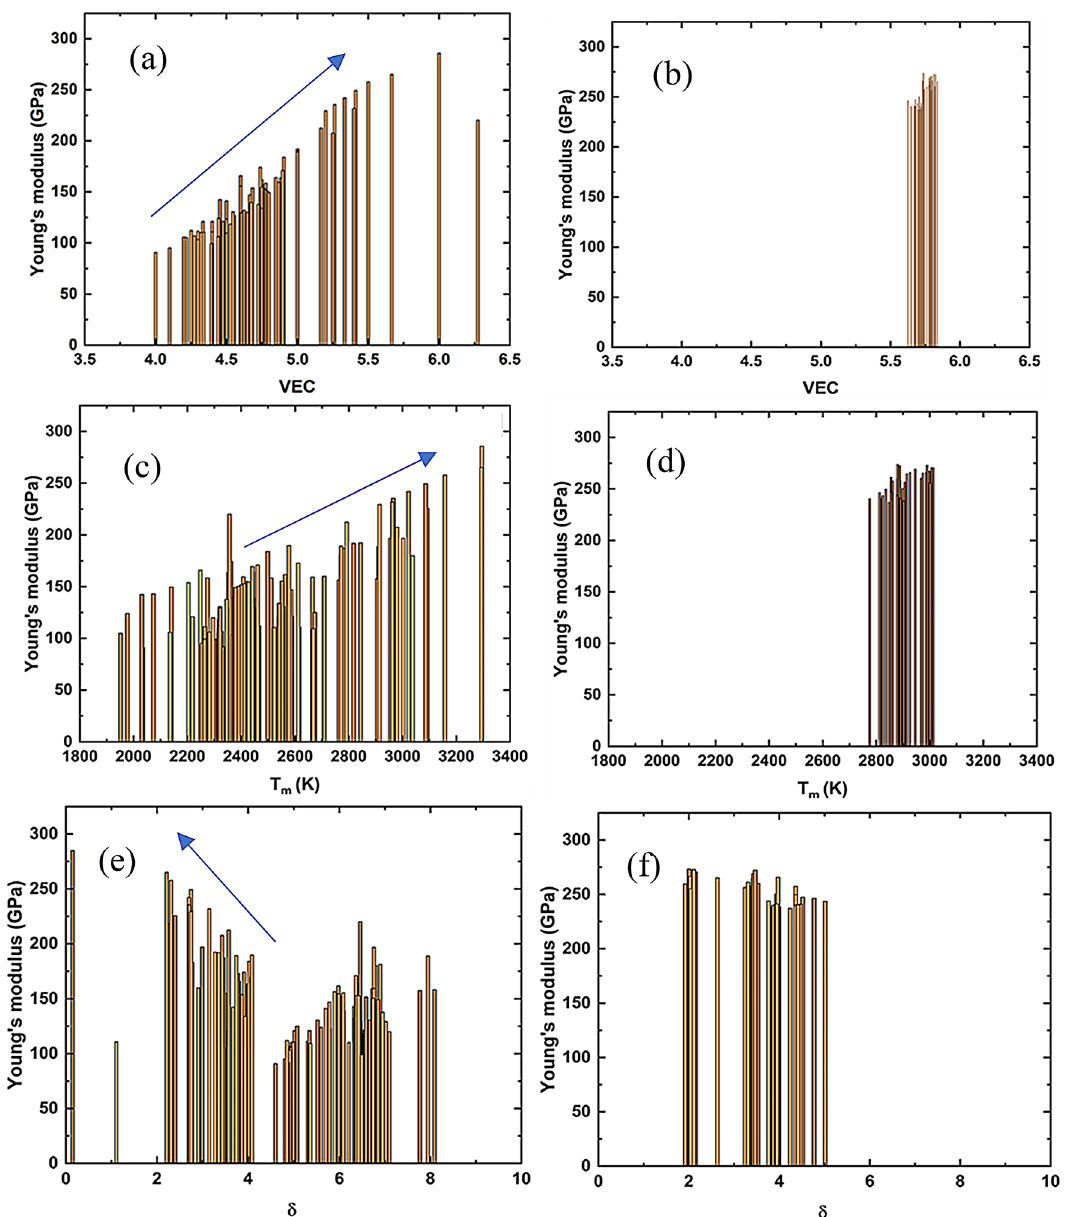
Figure 3. Impact of of some prominent features on Young’s modulus. (a) Relation between Young’s modulus and VEC for training set and (b) for experimental validation set. (c) Relation between melting temperature and Young’s modulus for training set and (d) for experimental validation set. (e) Relation between the difference of atomic radii and Young’s modulus for training set and (f) for experimental validation